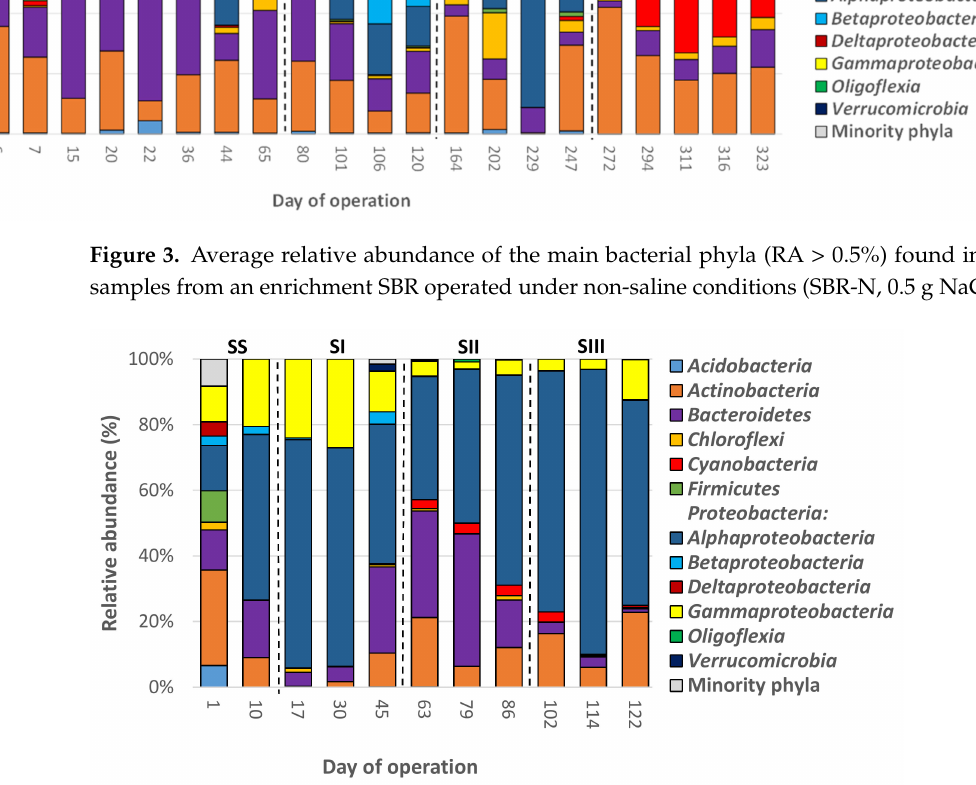
Figure 4. Average relative abundance of the main bacterial phyla (RA > 0.5%) found in biomass samples from an enrichment SBR operated under saline conditions (SBR-S, 10 g